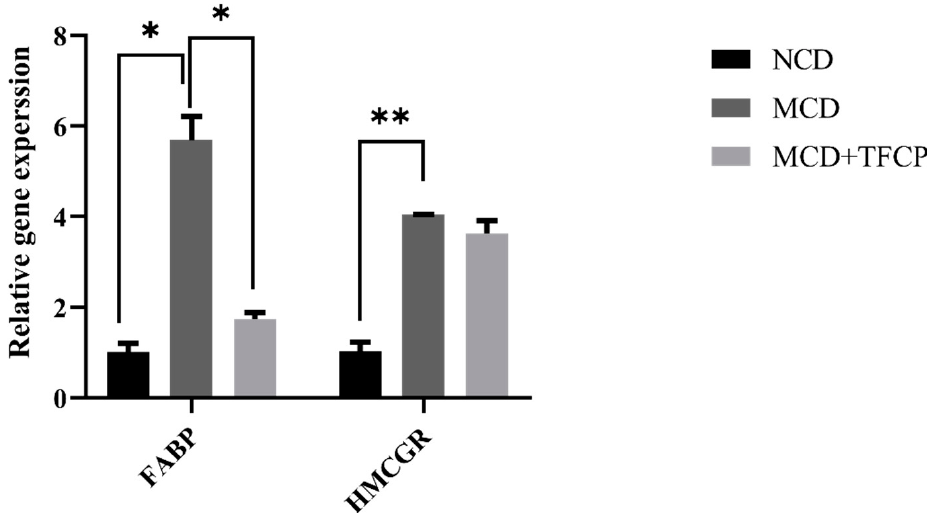
Figure 3. The TFCP-induced suppression in the cholesterol synthesis and transport in MCD-fed mice. Mice were fed with MCD or the control diet for six weeks, while the intragastric administration of TFCP to MCD-fed mice was performed daily. The mRNA levels of FABP and HMCGR genes were measured by qPCR. The means ± SEM of the results in the graph were obtained using NCD ( n = 5), MCD diet-fed group ( n = 5), and MCD + TFCP ( n = 5). Data were shown as the mean ± SEM (** p < 0.01, * p <